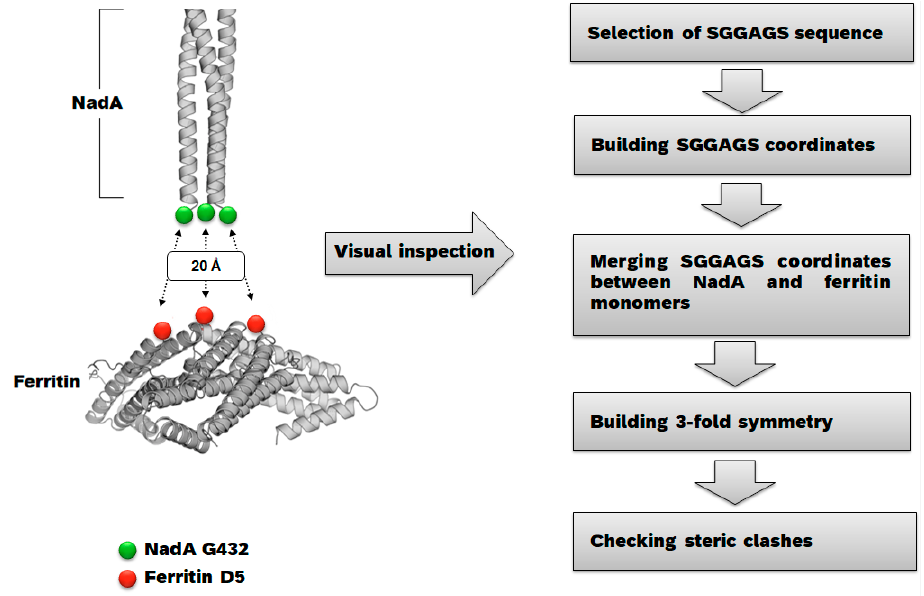
Figure 6. Flow diagram recapitulating the nanoparticle design procedure.